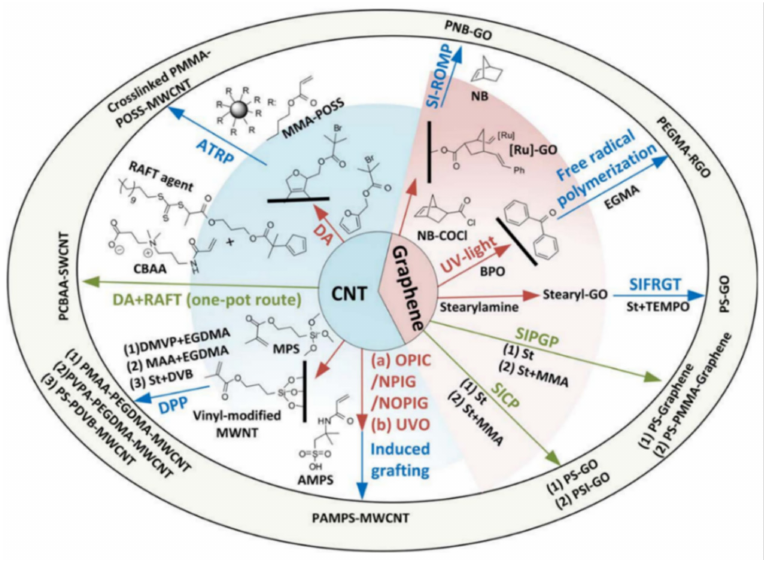
Figure 12. Covalent functionalization using the “grafting from” approach [105]. Reproduced with permission.